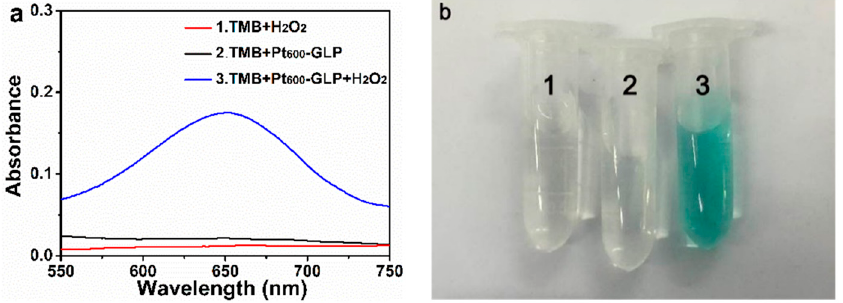
Figure 6. ( a ) UV-Vis spectra and ( b ) picture of the reaction product: (1) TMB + H 2 O 2 , (2) TMB + Pt 600 -GLP NCs, and (3) TMB + Pt 600 -GLP NCs + H 2 O 2 . Concentrations: TMB, 0.6 mM; Pt, 0.78 mM; H 2 O 2 , 0.3 M.